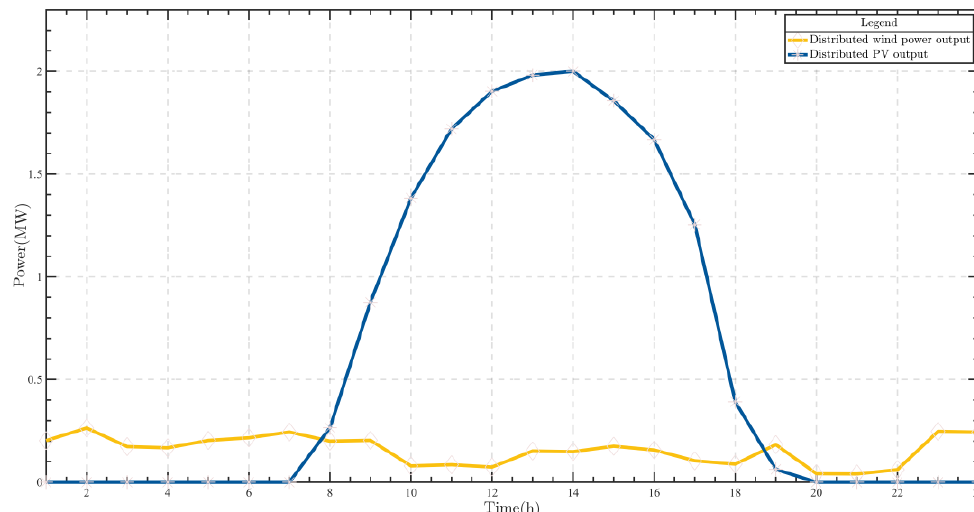
Figure A2. The output of distributed wind and photovoltaic power units.